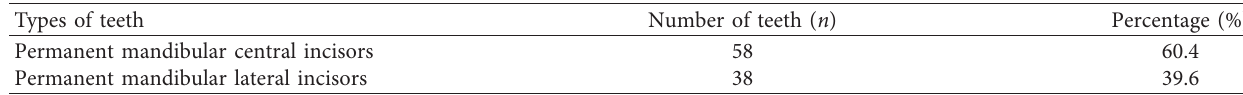
Table 2: Baseline distribution of types of mandibular incisors.